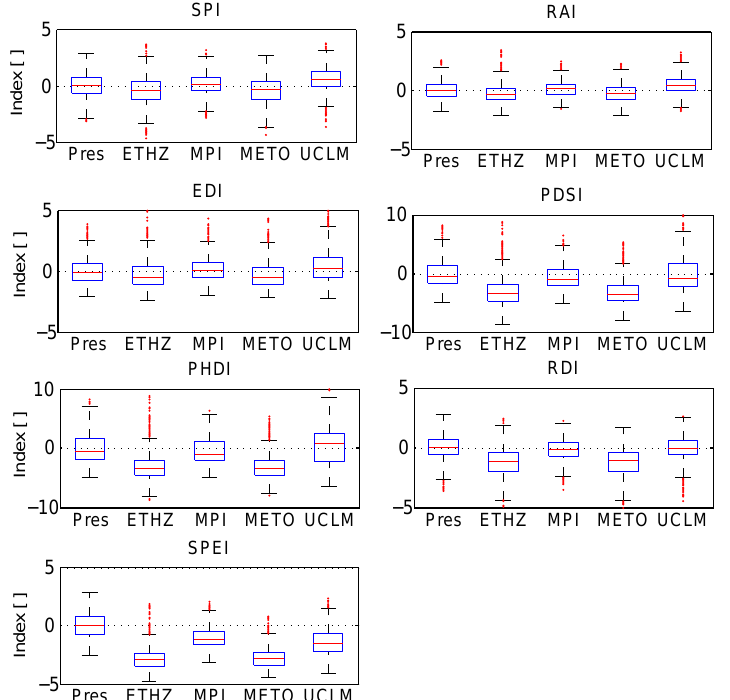
Figure 8. Present and future (2040–2050) droughts predicted by the seven drought indices, using the outputs from the weather generator. See Table 2 for information about the four regional climate